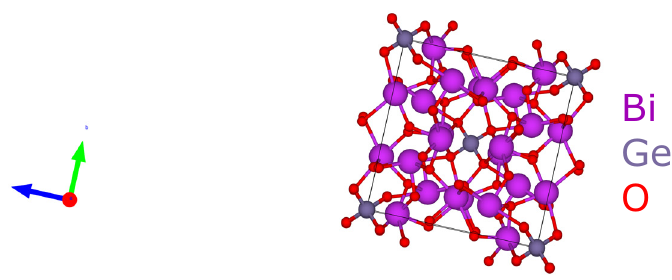
Figure A1. Crystal cell structure of BGO .